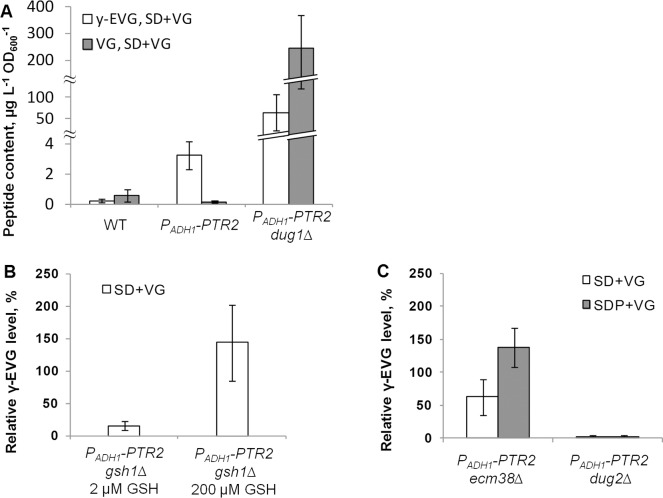
Identification of the enzyme responsible for γ-EVG synthesis from VG.A, Effect of overexpression of PTR2 and deletion of DUG1 on intracellular VG and γ-EVG concentrations. The strain S288C ura3Δ0 was used as a control (WT). B. Effect of GSH concentration on γ-EVG synthesis by the PADH1-PTR2 gsh1Δ strain. C. Effect of deletion of ECM38 or DUG2 on γ-EVG synthesis by the PADH1-PTR2 strain. In B and C, the level of γ-EVG in the PADH1-PTR2 strain cultivated in the corresponding medium was taken to be 100%.